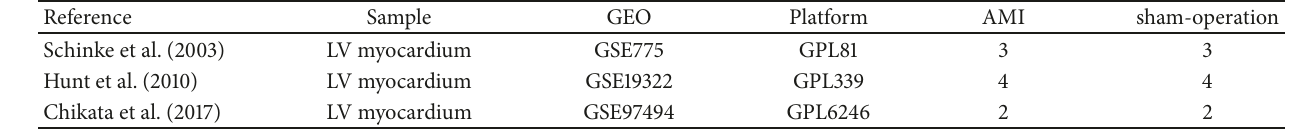
Table 1: Details for GEO AMI